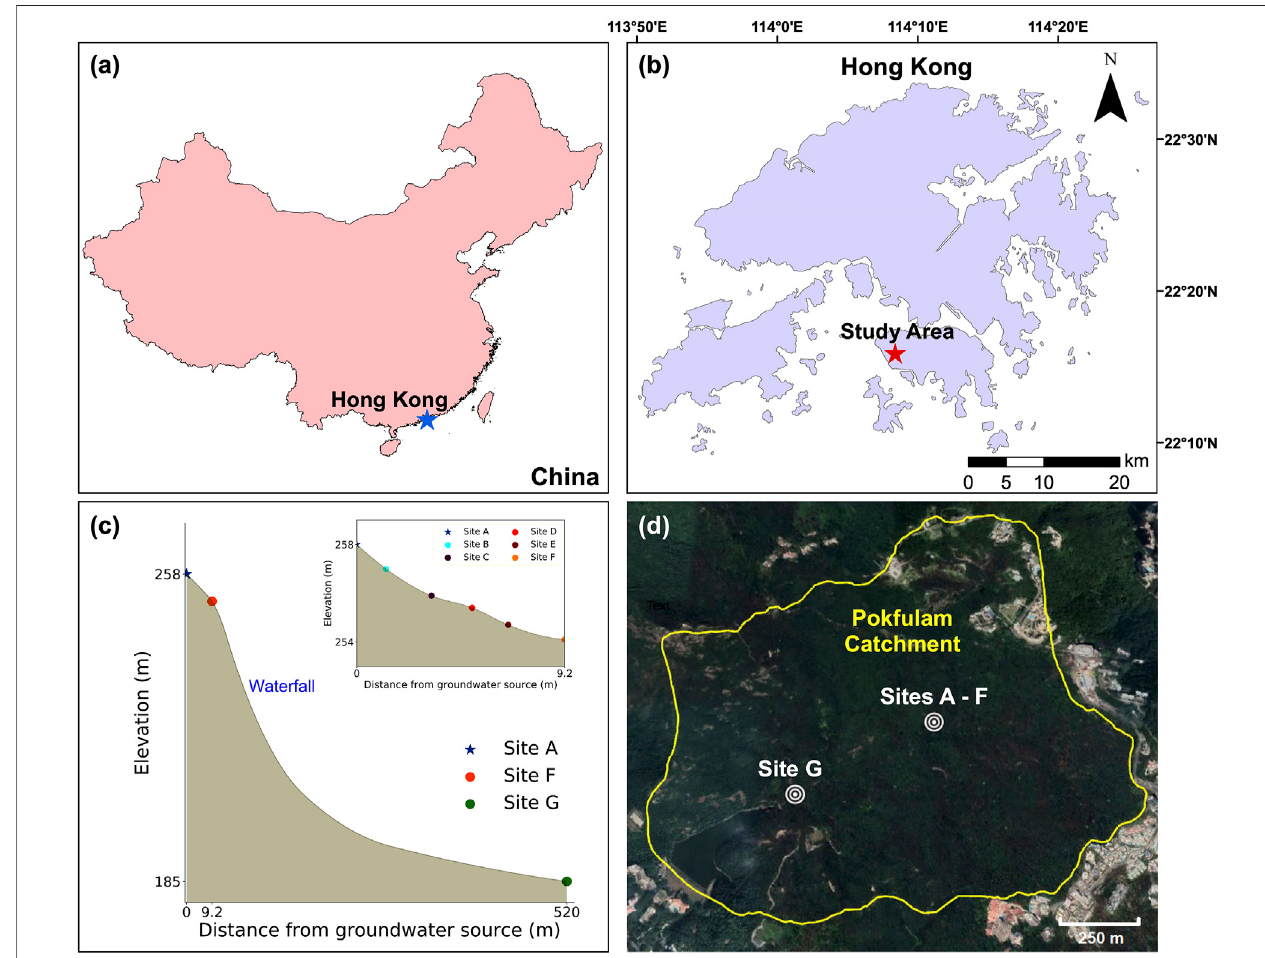
FIGURE 1 | Location map of the study area (A,B) , the schematic diagram showing the changes in elevation from site A to G (not scaled) (C) , and the enlarged satellite image obtained from Google Earth showing the locations of the study sites, i.e., sites A — F and site G and the boundary of the Pokfulam catchment (D) .